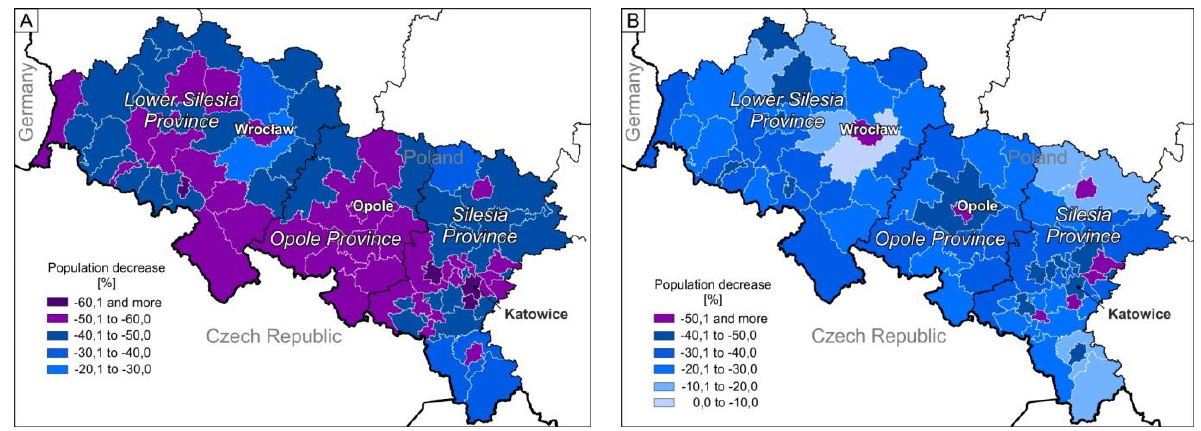
Fig. 1A. Population changes between 2000-2010 by counties Fig. 1B. Population changes between 2010-2017 by counties Table 2. Dynamics of population groups – age 16-18 and age 19-24, 2000-2017 (Source: authors own based on data from